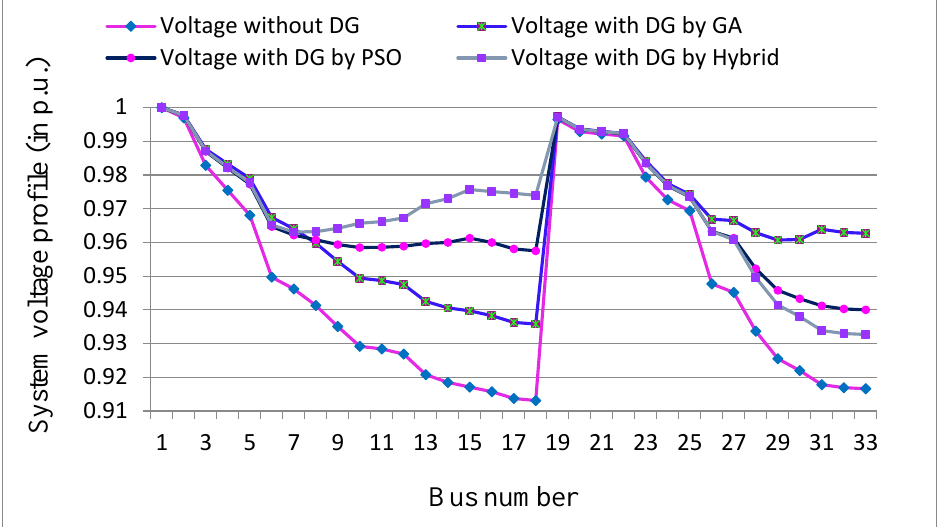
Figure 9. System voltage profile using PEM based load flow method and GA, PSO, and hybrid based optimization technique for scenario-2 with and without DG unit.